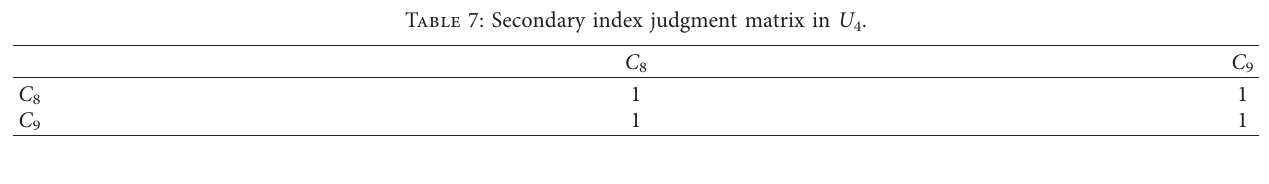
Table 8: Secondary index judgment matrix in U